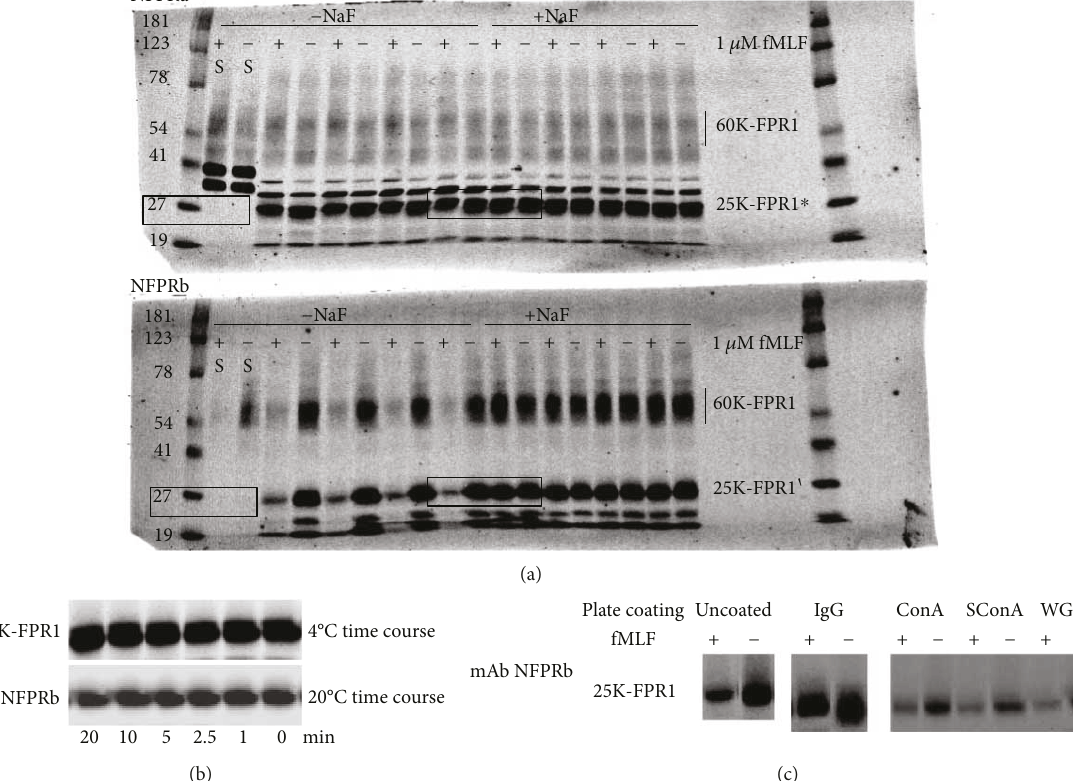
Figure 2: 25K-FPR1( ∗ ) is insensitive to modulating physiologic conditions. (a) The 25K-FPR1( ∗ ) bands persist when adherent PMNs are depleted of ATP. Adherent PMN were incubated with DPBS that contained 40mM NaF, replacing 40 mM NaCl in the composition of DPBS bu ff er, prior to treatment with 1 μ M fMLF or vehicle for 10 min as described in the legend of Figure 1. The 25K-FPR1 or 25K-FPR1 ∗ bands in line with the Mr 25kDa are boxed for clarity. The treatment of the cells with or without NaF (+/ − ) or fMLF (+/ − ) are so marked in the upper two rows adjacent to their respective labels. The fi rst two lanes, marked “ S ” adjacent to the 25 K marker (boxed left), show no density in either NaF-treated (+) or untreated ( − ) PMN indicating that no Mr =25K bands are being generated by suspension PMN when they are fMLF-treated (+) or untreated ( − ). The center boxed 4 lanes show the density of the 25K band in adherent cells for NFPRa (upper) and NFPRb (lower). One of three experiments. (b) The 25K-FPR1 persists una ff ected when PMN are allowed to adhere at low temperature. Adherent PMN were not centrifuged but allowed to adhere by settling for 0 to 20min either at 20 ° C (lower) or 4 ° C (upper) before extraction by TS bu ff er. The 25K-FPR1 was digitally excised from the NFPRb immunoblot scan. The density of the 4 ° C 25K-FPR1 band appears to be higher than that of the 25K band generated after the 25 ° C settling assay because they represent di ff erent plates incubated at di ff erent temperatures. Plate to plate variation is greater than well to well variation. One of two experiments. (c) The 25K-FPR1 persists when PMN are allowed to adhere onto di ff erent coatings. Wells of 96-well microtiter plates were incubated with 100 μ L of 1mg/ml autologous human IgG, ConA, succinyl ConA (SConA), wheat germ agglutinin (WGA), and protein-free DPBS. The 25K-FPR1 band was digitally excised from the NFPRb immunoblot scans and is displayed showing the density of the 25K-FPR1 from adherent cells stimulated (+) and unstimulated ( − ) with 1 μ M fMLF. Scanned blots showing di ff erent coatings were derived from di ff erent experiments on di ff erent days and so are not correlated in density with one another. One of four